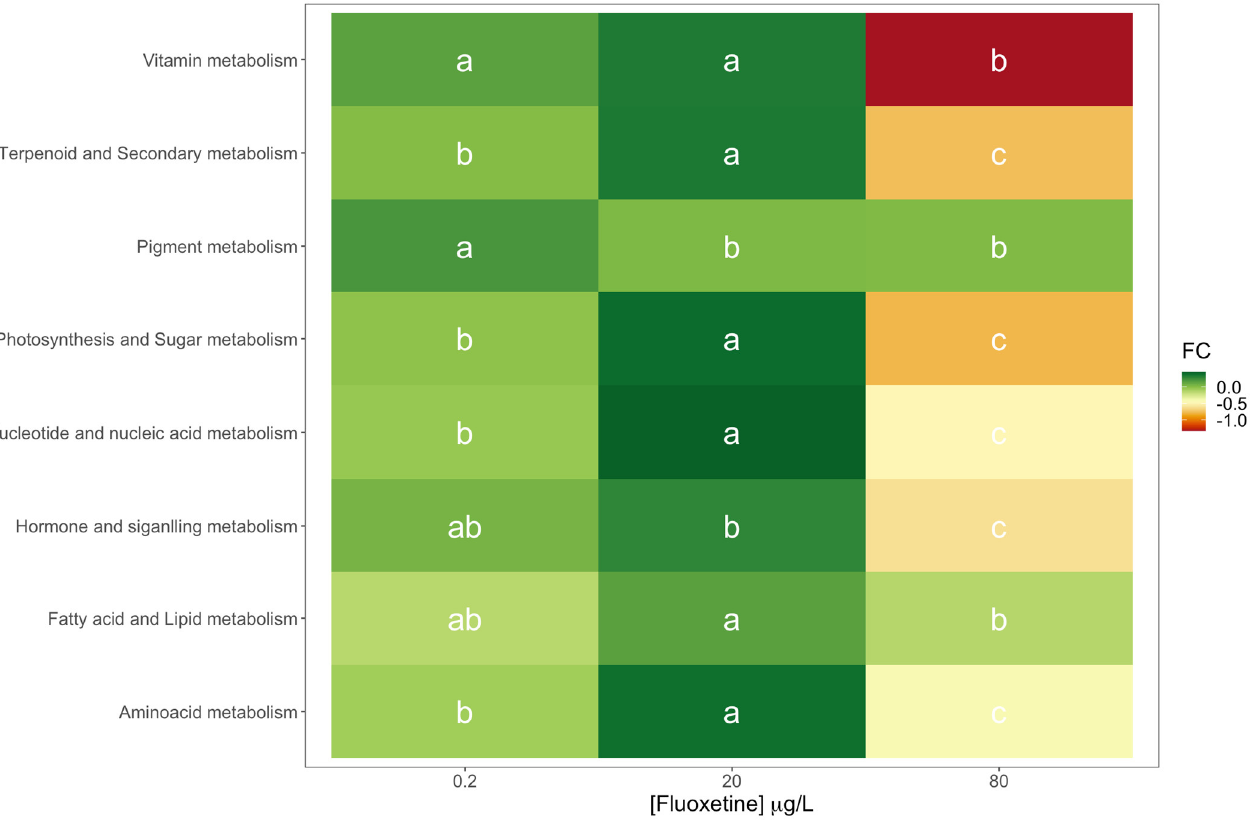
Figure 4. Fold-change heatmap of the different metabolic networks identified in the diatom cells exposed to 0.2, 20 and 80 µg/L fluoxetine ( n = 3, different letters denote significant differences at p < 0.05).